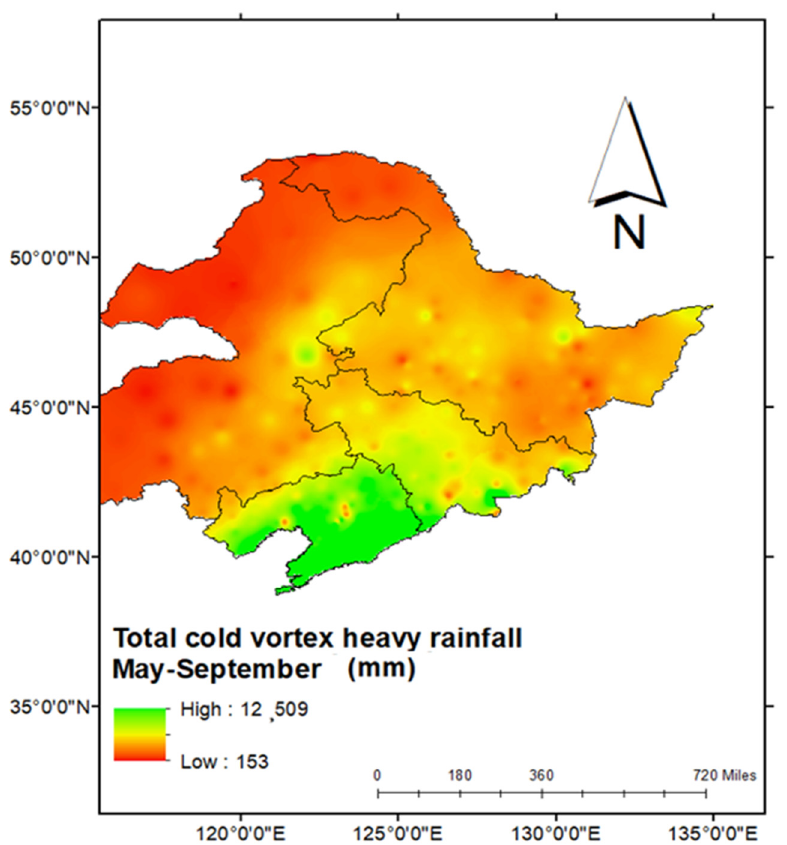
Figure 2. Climatology of heavy rainfall under cold vortex during May–September (1961–2019) (mm, shaded).